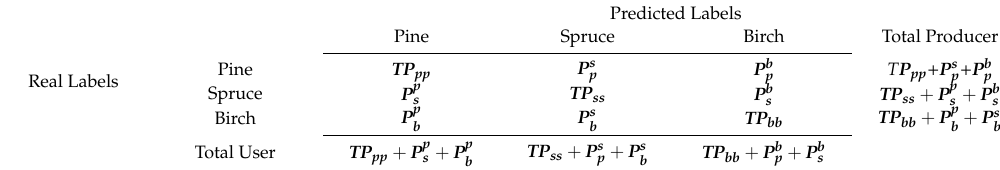
Table A1. Confusion matrix of the classification problem with three